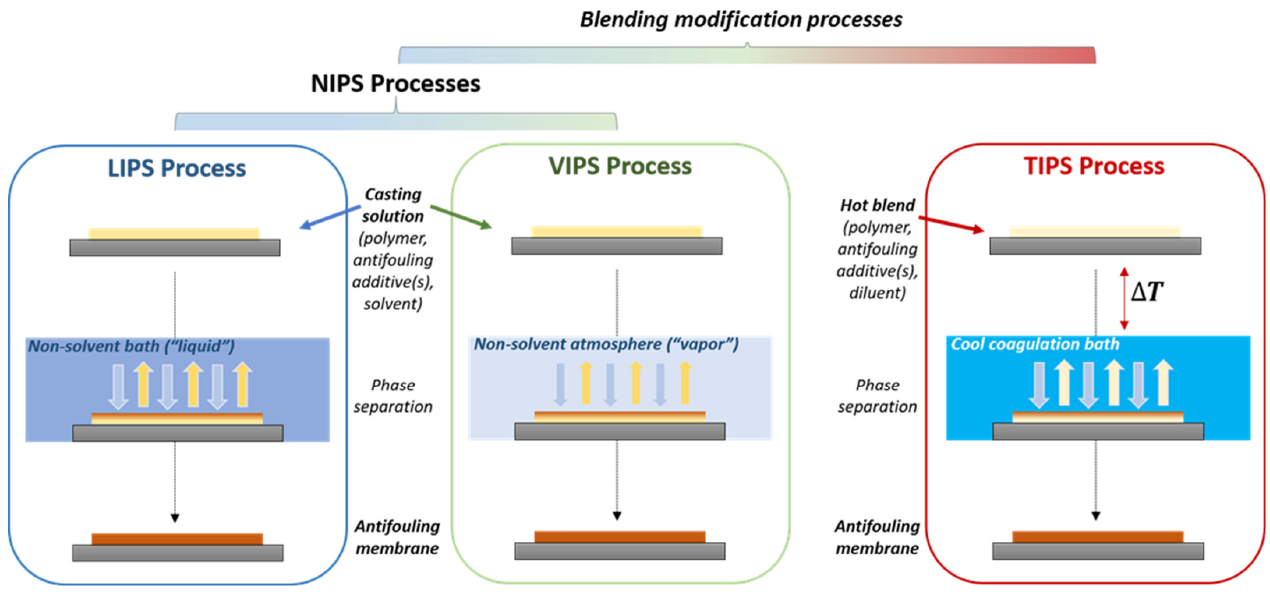
Figure 1. Schematic of phase-inversion processes for the formation of flat-sheet antifouling porous membranes via blending modification.